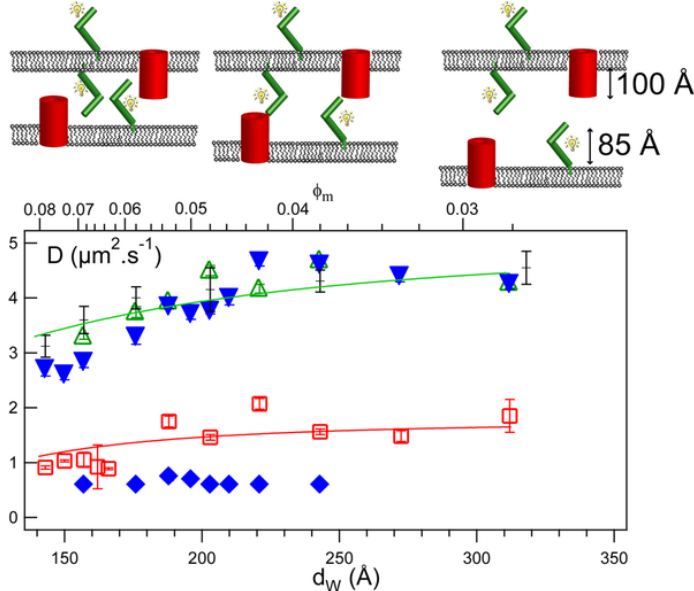
Figure 6. MexA-OprM interactions as a function of bilayer separation distance (d ). The w top panel is a schematic representation of the interactions between the proteins, with the barrels representing OprM and boomerang-like sticks representing MexA. Each schematic in the upper panel corresponds to proposed interactions between the two proteins as a function of d where the middle one is representative of interactions at ~200Ǻ. The bottom w panel is a plot of diffusion coefficients as a function of bilayer distance. The symbols correspondence is as follows; green (empty) triangles pointing up; FITC-labelled MexA alone, blue (full) triangles pointing down; non-bound MexA in a sample containing OprM trimers, black crosses; FITC-C (a fluorescently labelled SOPC lipid) alone, red squares; 16 OprM alone, blue (full) diamonds; MexA bound to OprM. From [31], by permission from PLoS